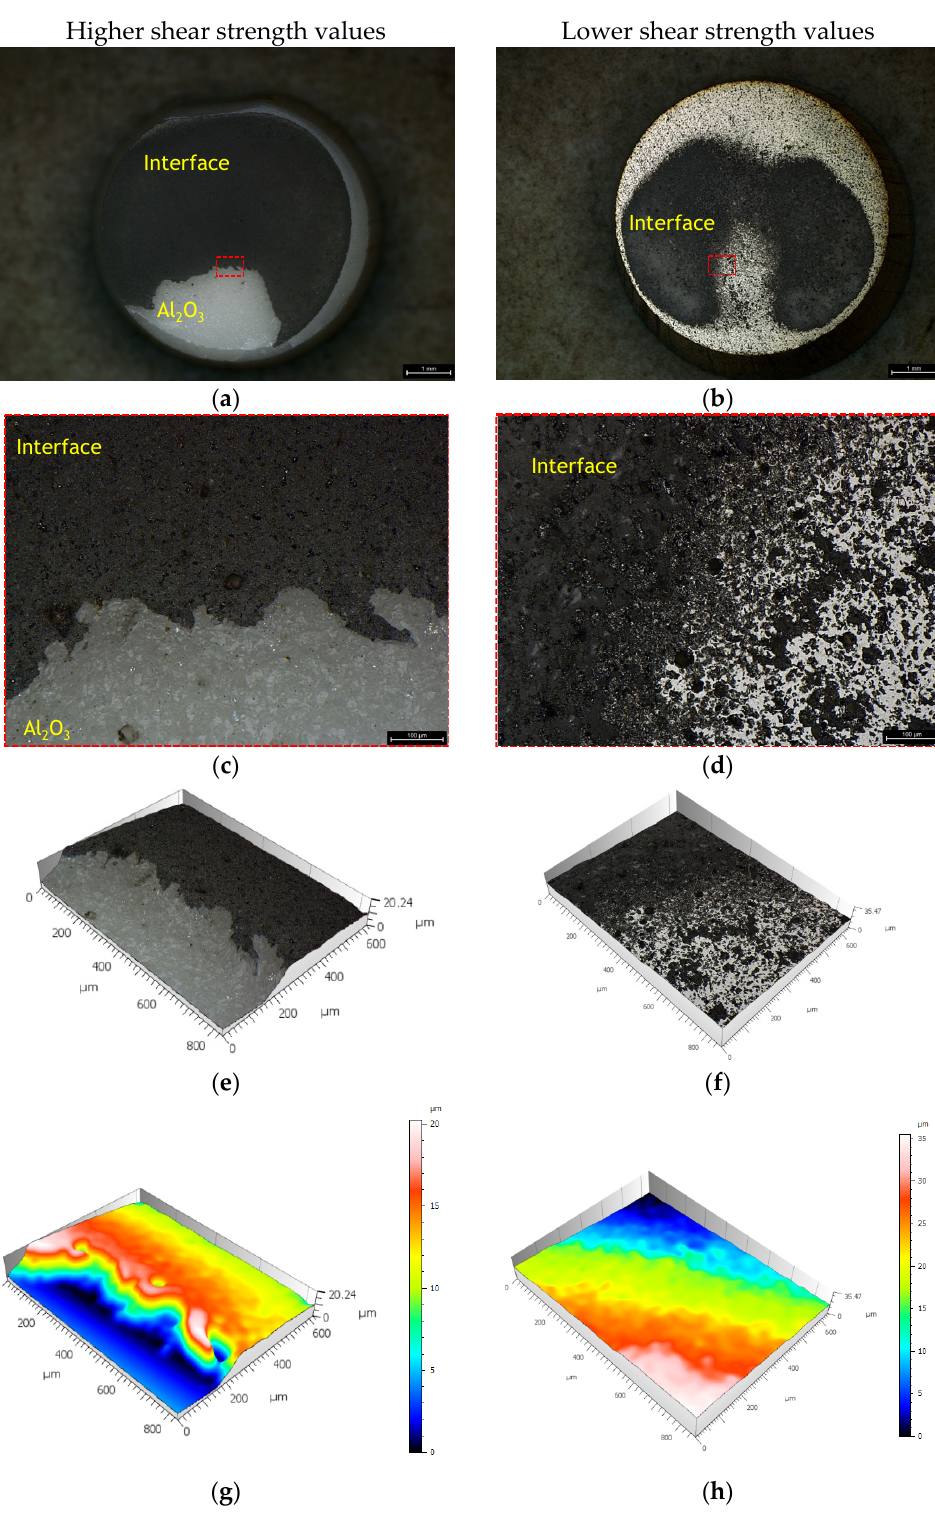
Figure 9. Fracture surface of the joints with ( a,c,e,g ) higher and ( b,d,f,h ) lower shear strength values: ( a ) and ( b ) low magnification of the Al 2 O 3 samples, ( c ) and ( d ) high magnification of the regions marked in ( a ) and ( b ), respectively, ( e,f,g,h ) 3D representation of regions ( c ) and ( d ).